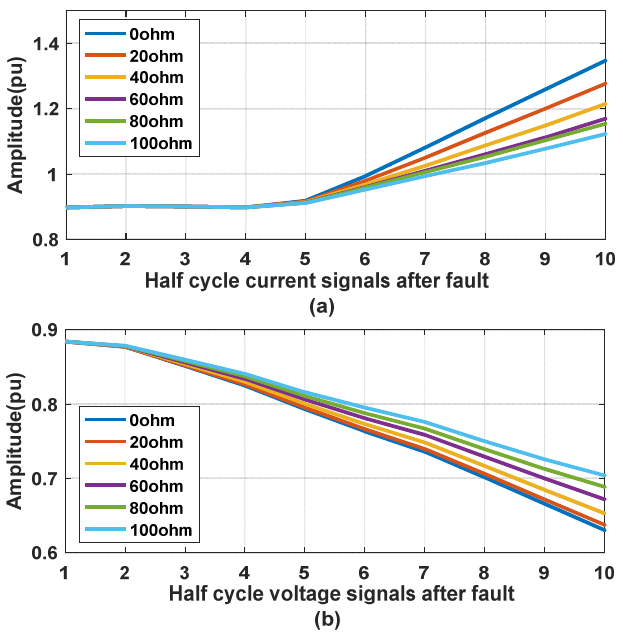
Figure 5. ( a ) Half cycle rms current and ( b ) Half cycle rms voltage during P1G fault at 1080 km for various fault resistance.